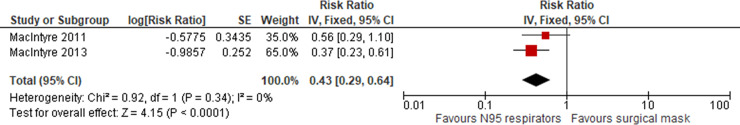
Forest plot of Clinical Respiratory Illness (CRI)–random effect model meta-analysis with 95% CI.